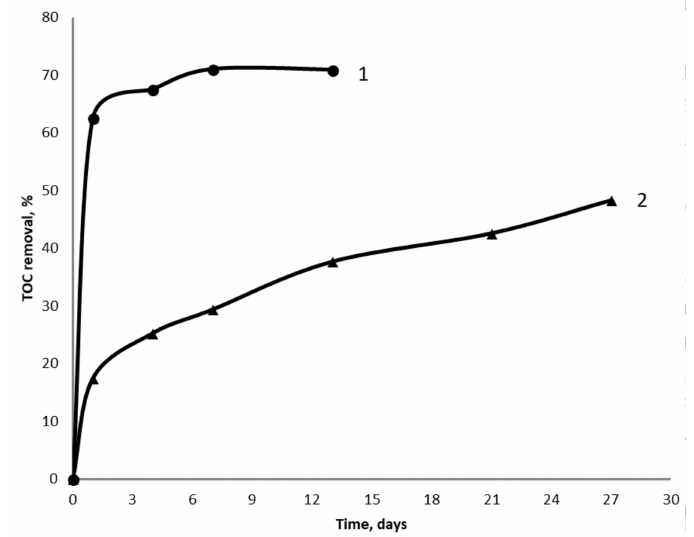
Figure 2. The removal of TOC in the laboratory facility operated in batch mode with either fresh iron ore (curve 1) or used iron ore (curve